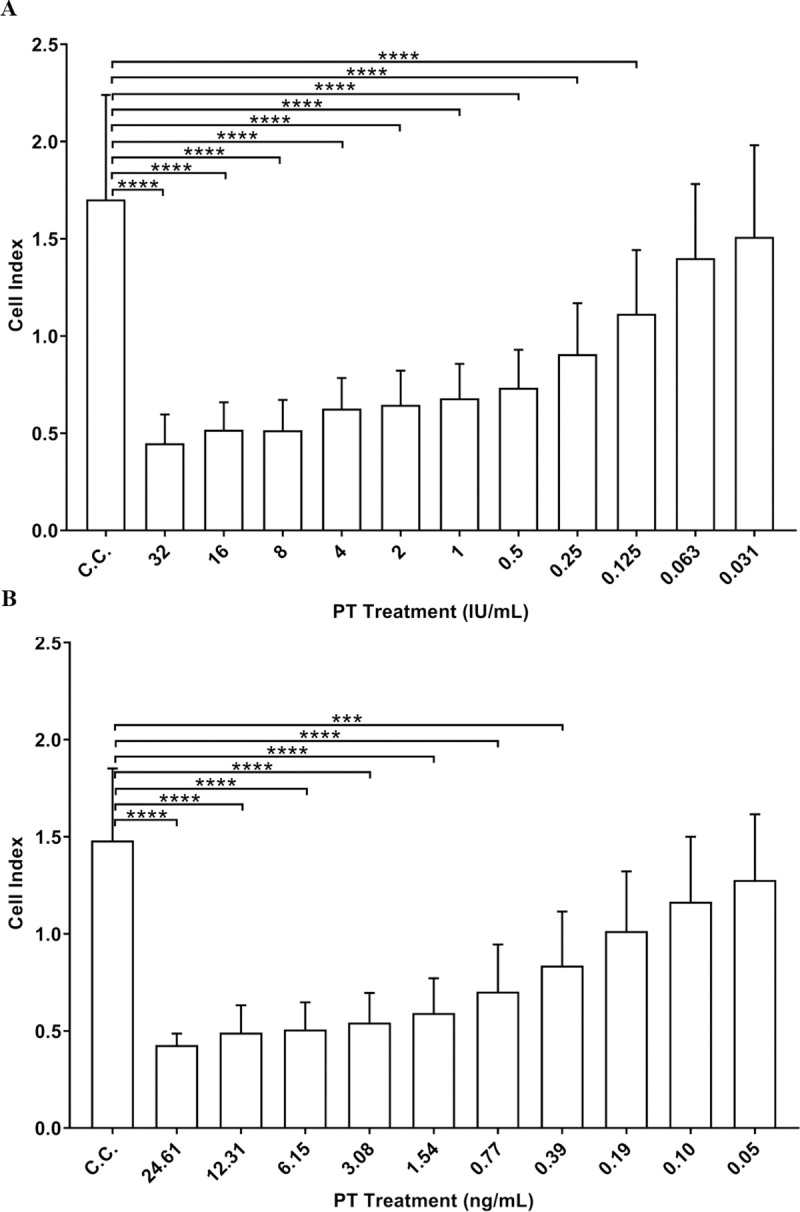
Mean cell index of pertussis toxin treatments versus cell control.(A) Standard pertussis toxin results with at least n = 15 for each toxin treatment and n = 302 for cell control (C.C.). (B) In-house pertussis toxin with at least n = 7 for each toxin treatment and n = 60 for C.C. condition. Statistical analysis was performed by Kruskal-Wallis test followed by Dunn’s multiple comparison test (GraphPad Prism v. 8.0) (**** p <0.0001, *** p < 0.001). Error bars represent standard deviations.